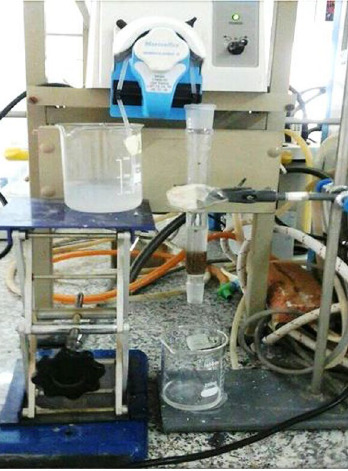
Fig. 2 Dairy effluents filtration using a clay fixed-bed adsorption sys- tem ( Source: Original,